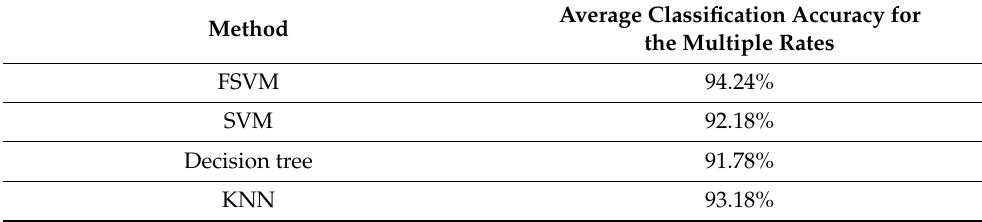
Figure 7. The optimization process of the model parameters is under BW = 500 khz SF = 12. ( a ) Optimal C solving; ( b ) Optimal b solving. Table 3. Comparison of the different classification models.